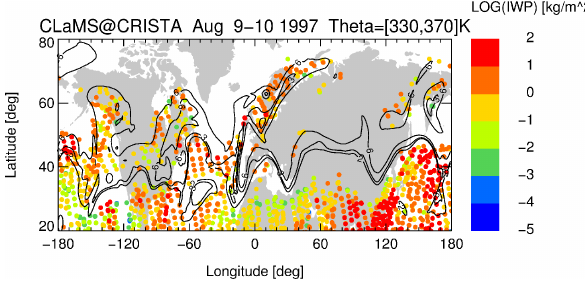
Figure 8. Limb ice water path based on derived from CLaMS IWC integrated along CRISTA line of sights for 10 August 1997 at 00:00 UTC ± 12h between the 330 and 370K isentrope (for details see text). PV contours for 2, 3, and 6 PVU are